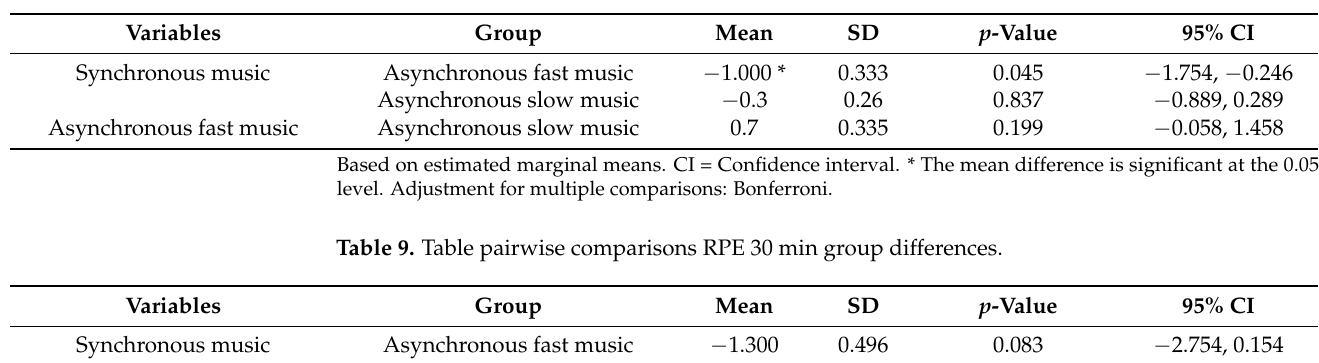
Table 8. Table pairwise comparisons RPE 25 min group differences.